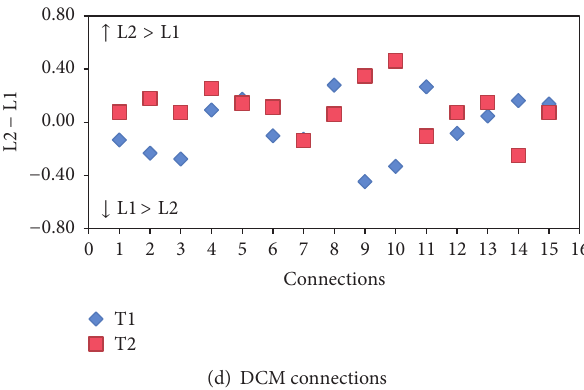
Figure 6: Patient 4. (a) The T1-weighted MRI image at T1 shows a left sylvian ischemic stroke. (b) Pattern of brain activation in different conditions while picture naming, with an uncorrected 𝑝 < 0.001 for the main effects. (c) Behavioral results of the combined production scores in both languages, linguistic and nonlinguistic switching scores across sessions. ∗ represents 𝑝 value < 0.05. (d) Differences between L1 strength values and L2 strength values for each single connection across sessions. (1) ACC to LIFGTri. (2) ACC to LIFGOrb. (3) ACC to LC. (4) LC to ACC. (5) LC to LIFGTri. (6) LC to LIFGOrb. (7) LIFGTri to LC. (8) LIFGTri to ACC. (9) LIFGOrb to LC. (10) LIFGOrb to ACC. (11) LIFGTri to LIFGOrb. (12) LIFGOrb to LIFGTri. (13) BTLA to LIFGTri. (14) BTLA to LIFGOrb. (15) BTLA to